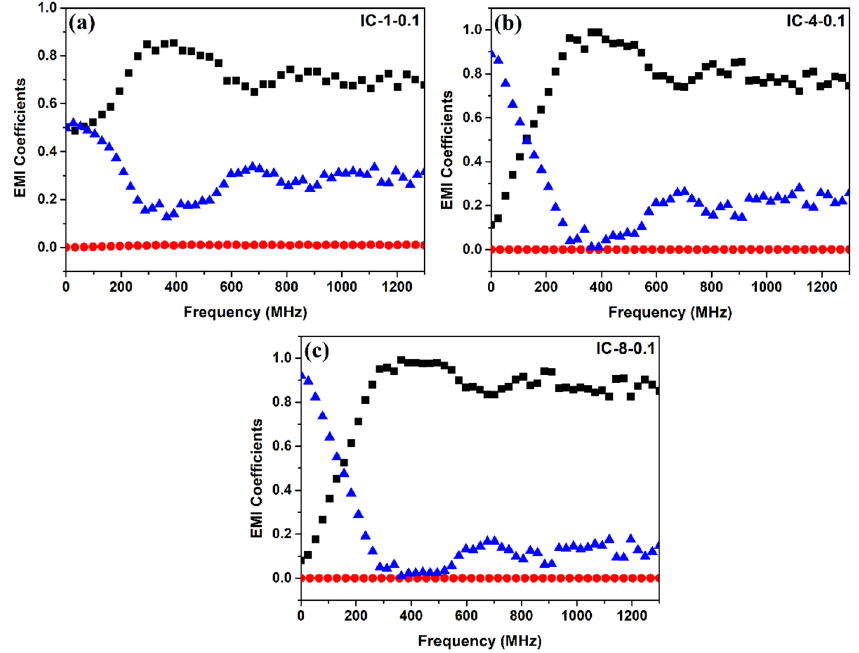
Figure 7. EMI power coefficients of reflectance ( ), transmittance ( ), and absorbance ( ) of the interlayered composites: ( a ) IC - 1 - 0.1; ( b ) IC - 4 - 0.1; and, ( c ) IC - 8 - 0.1.